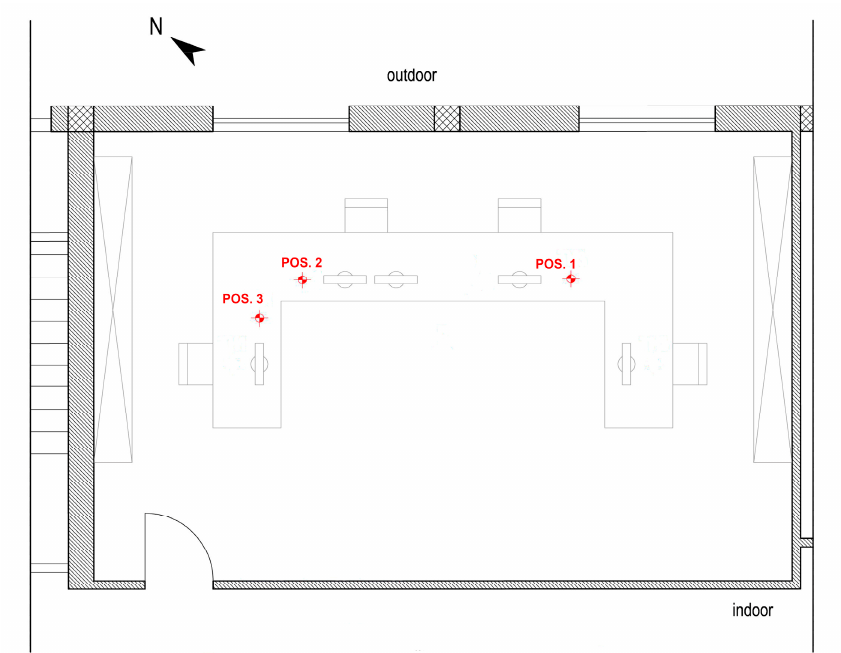
Figure 2. Monitoring system as installed in an office